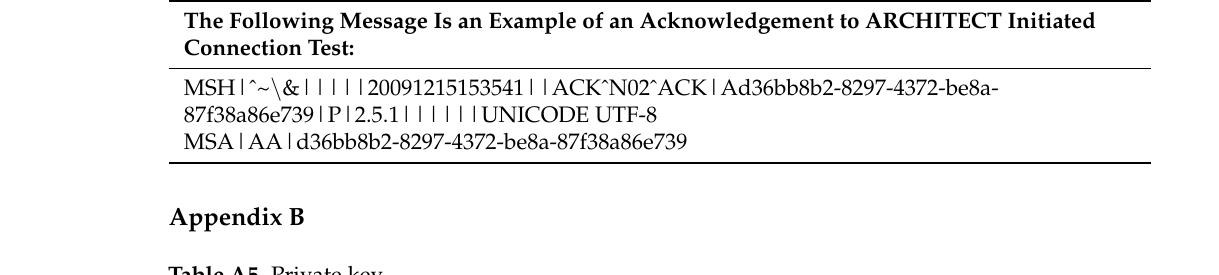
Table A5. Private key.